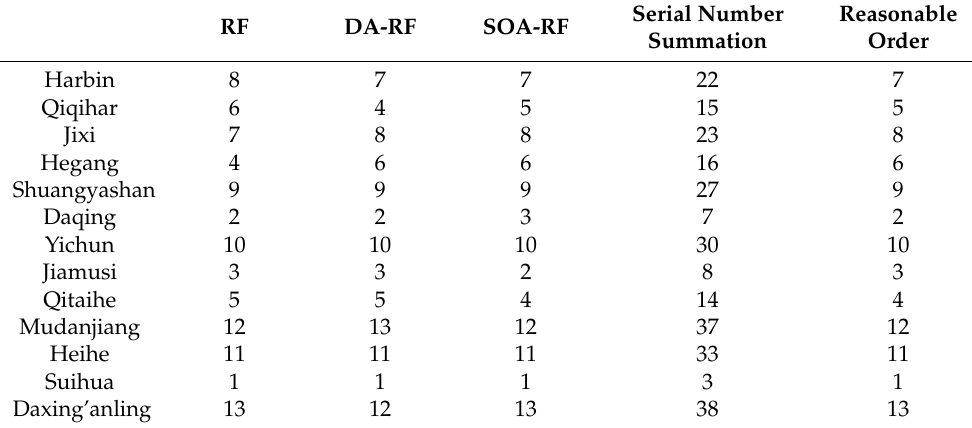
Table 6. The serial number summation and reasonable order.